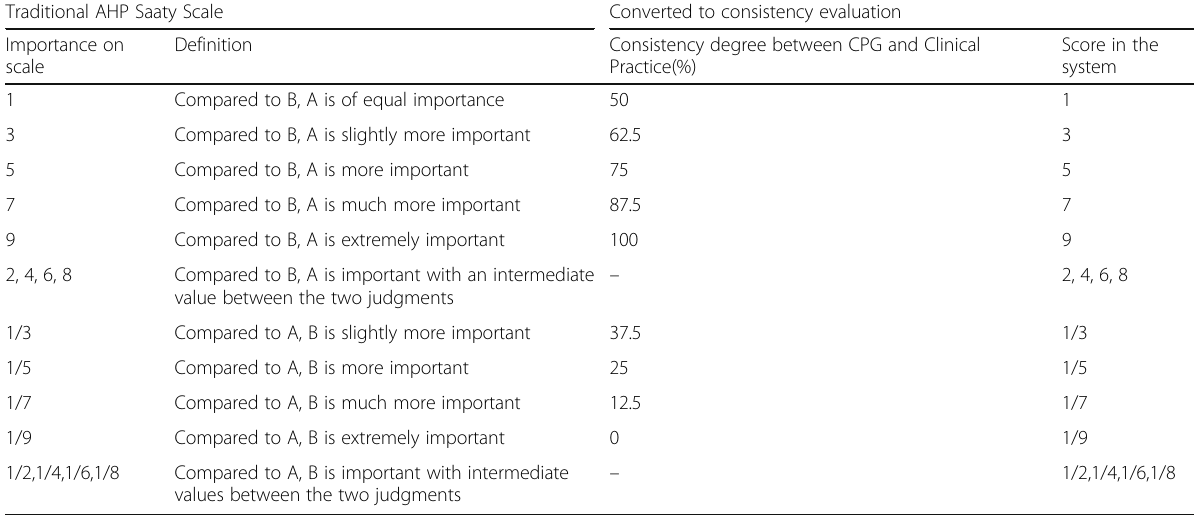
Table 2 Traditional AHP Saaty weight method, and with conversion to consistency evaluation Traditional AHP Saaty Scale